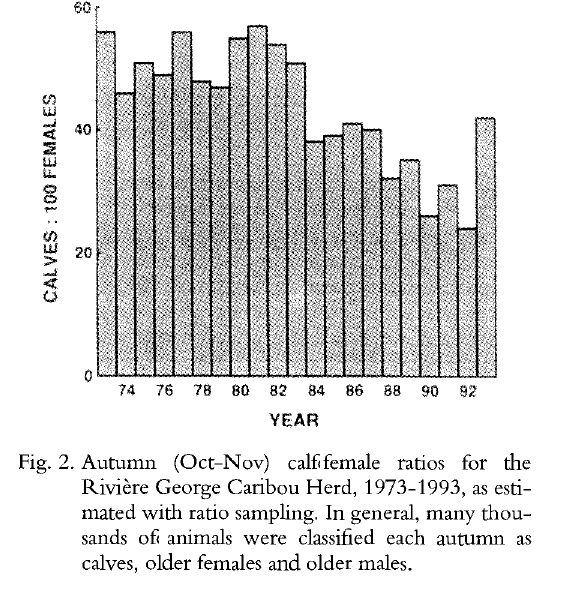
Fig. 2. Autumn (Oct-Nov) calffemale ratios for the Rivière George Caribou Herd, 1973-1993, as esti mated with ratio sampling. In general, many thou sands of animals were classified each autumn as calves, older females and older males.